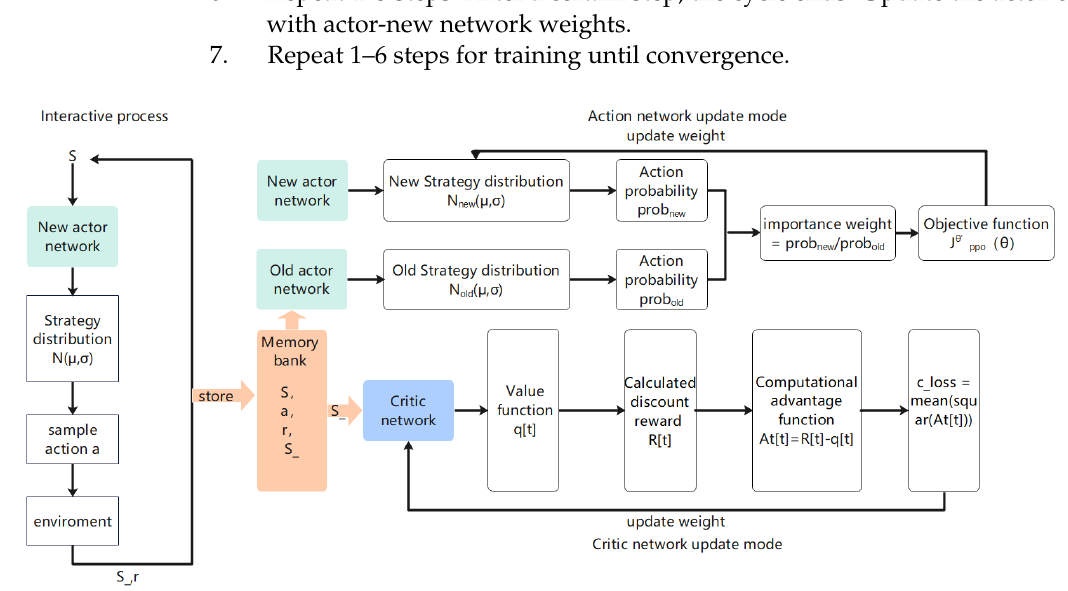
Figure 1. PPO algorithm flow